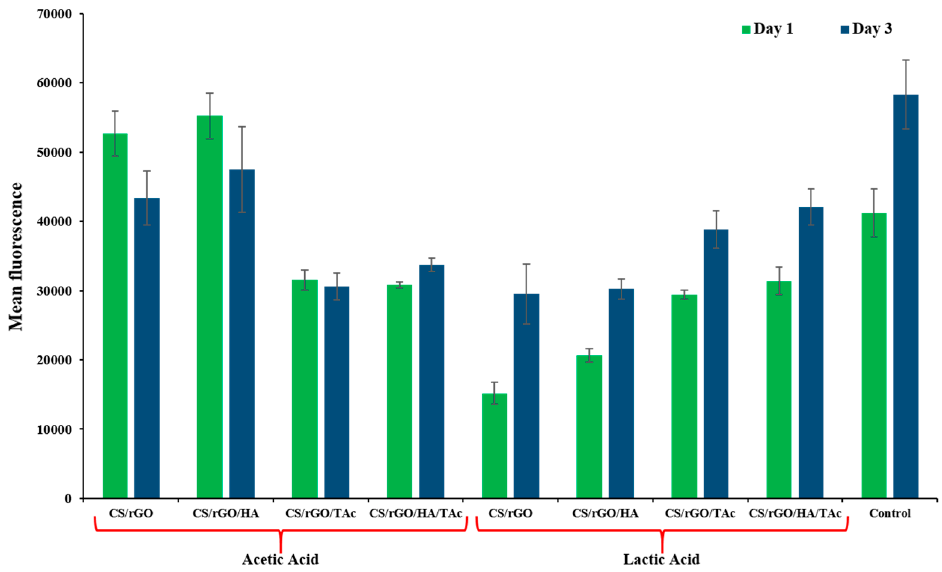
Figure 8. Alamar Blue assay—mean fluorescence after 24 h and 3 days (CS—chitosan, rGO—reduced graphene oxide, HA—hydroxyapatite, TAc—tannic